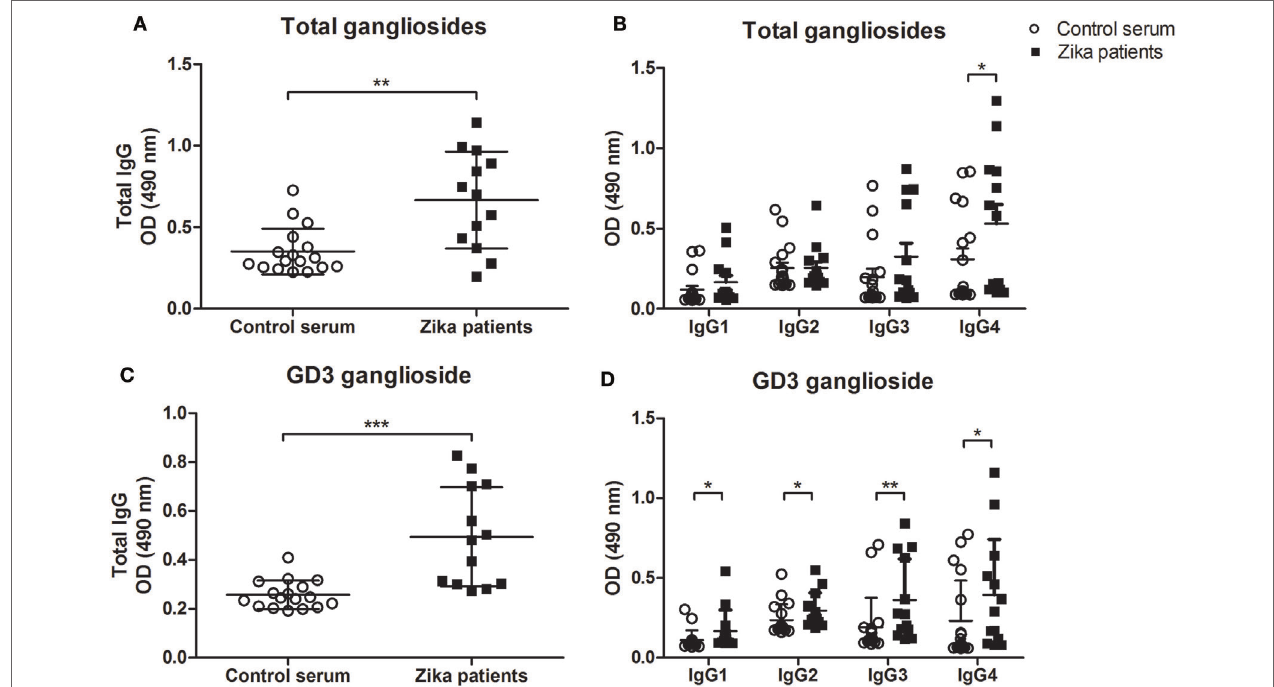
FigUre 1 | Autoantibody levels to gangliosides in Zika-infected patients and healthy control individuals. ELISA plates coated with the indicated gangliosides at 20 µg/ml in ethanol, followed by evaporation, were incubated with 1:100 dilution of sera from Zika patients or control healthy individuals and developed with anti-total IgG or anti-Ig-specific subclasses conjugated to HRP. Scatter plots show individual values for each Zika-infected patient ( n = 13) and healthy individual ( n = 17) for recognition of (a,c) IgG class autoantibodies and (b,D) IgG subclasses (IgG1, IgG2, IgG3, and IgG4 isotypes), against (a,b) total gangliosides (from bovine brain extract) or (c,D) purified ganglioside GD3. Each data point is the mean of triplicated determinations. Means of data points for each individual ± SE are shown. Differences between groups are significant *( p ≤ 0.05), **( p ≤ 0.01), ***( p ≤